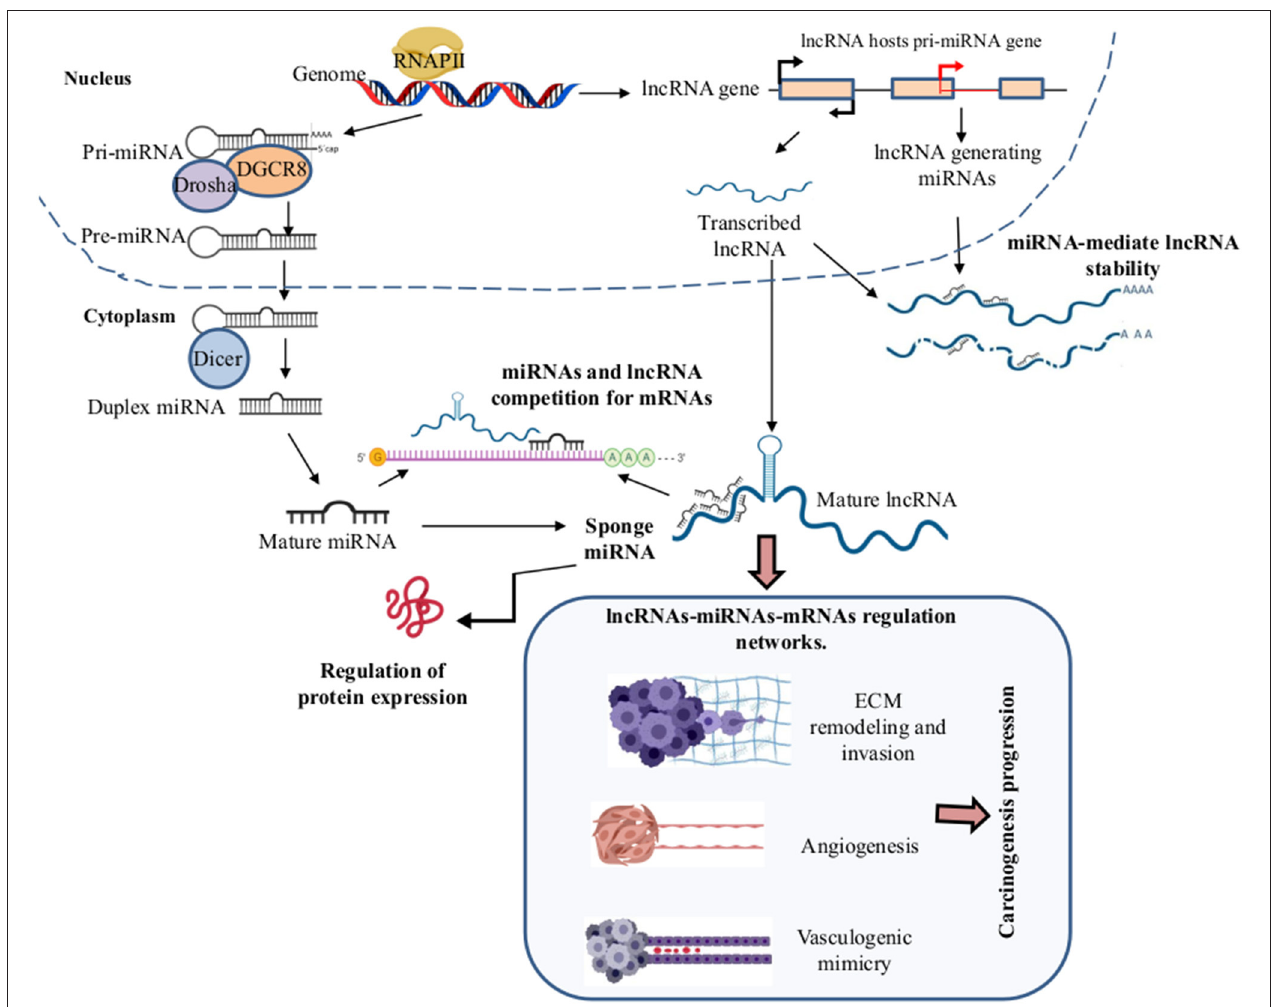
FIGURE 3 | Long non-coding RNAs (lncRNAlncRNAs)–microRNAs (miRNAs)–mRNAs regulation networks in the VM development. During the biogenesis of the miRNAs and lncRNAs in the nucleus by the RNAPII, the pri-miRNA and lncRNAs are exported to the cytoplasm where the mature miRNAs and lncRNAs are formed, respectively. In the cytoplasm, LncRNAs can function as sponges of miRNAs by competition for the binding to mRNA target genes, leading to the formation of complex regulatory networks of lncRNAs-miRNAs-mRNAs, promoting angiogenesis, extracellular matrix (ECM) remodeling, invasion, migration, EMT, metastasis, and VM formation in solid tumors. Created with